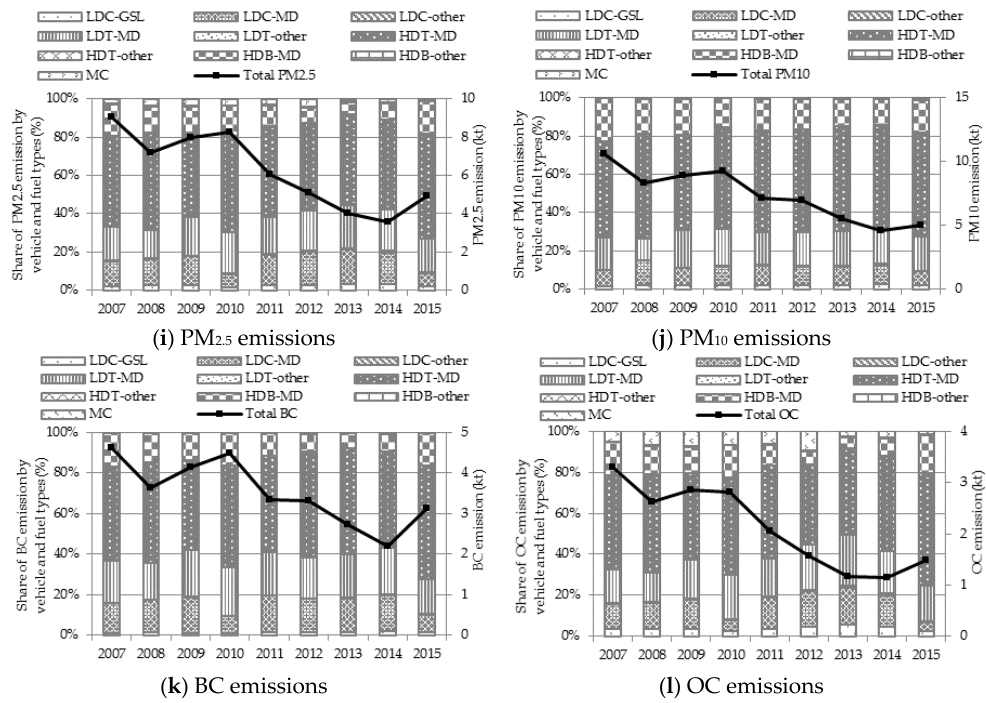
Figure 12. Share of emissions by vehicle and fuel types and trend of emissions from 2007 to 2015 for each emission species: ( a ) CO emissions; ( b ) NO X emissions; ( c ) NMVOC emissions; ( d ) CO 2 emissions; ( e ) CH 4 emissions; ( f ) N 2 O emissions; ( g ) SO 2 emissions; ( h ) NH 3 emissions; ( i ) PM 2.5 emissions; ( j ) PM 10 emissions; ( k ) BC emissions; ( l ) OC emissions.